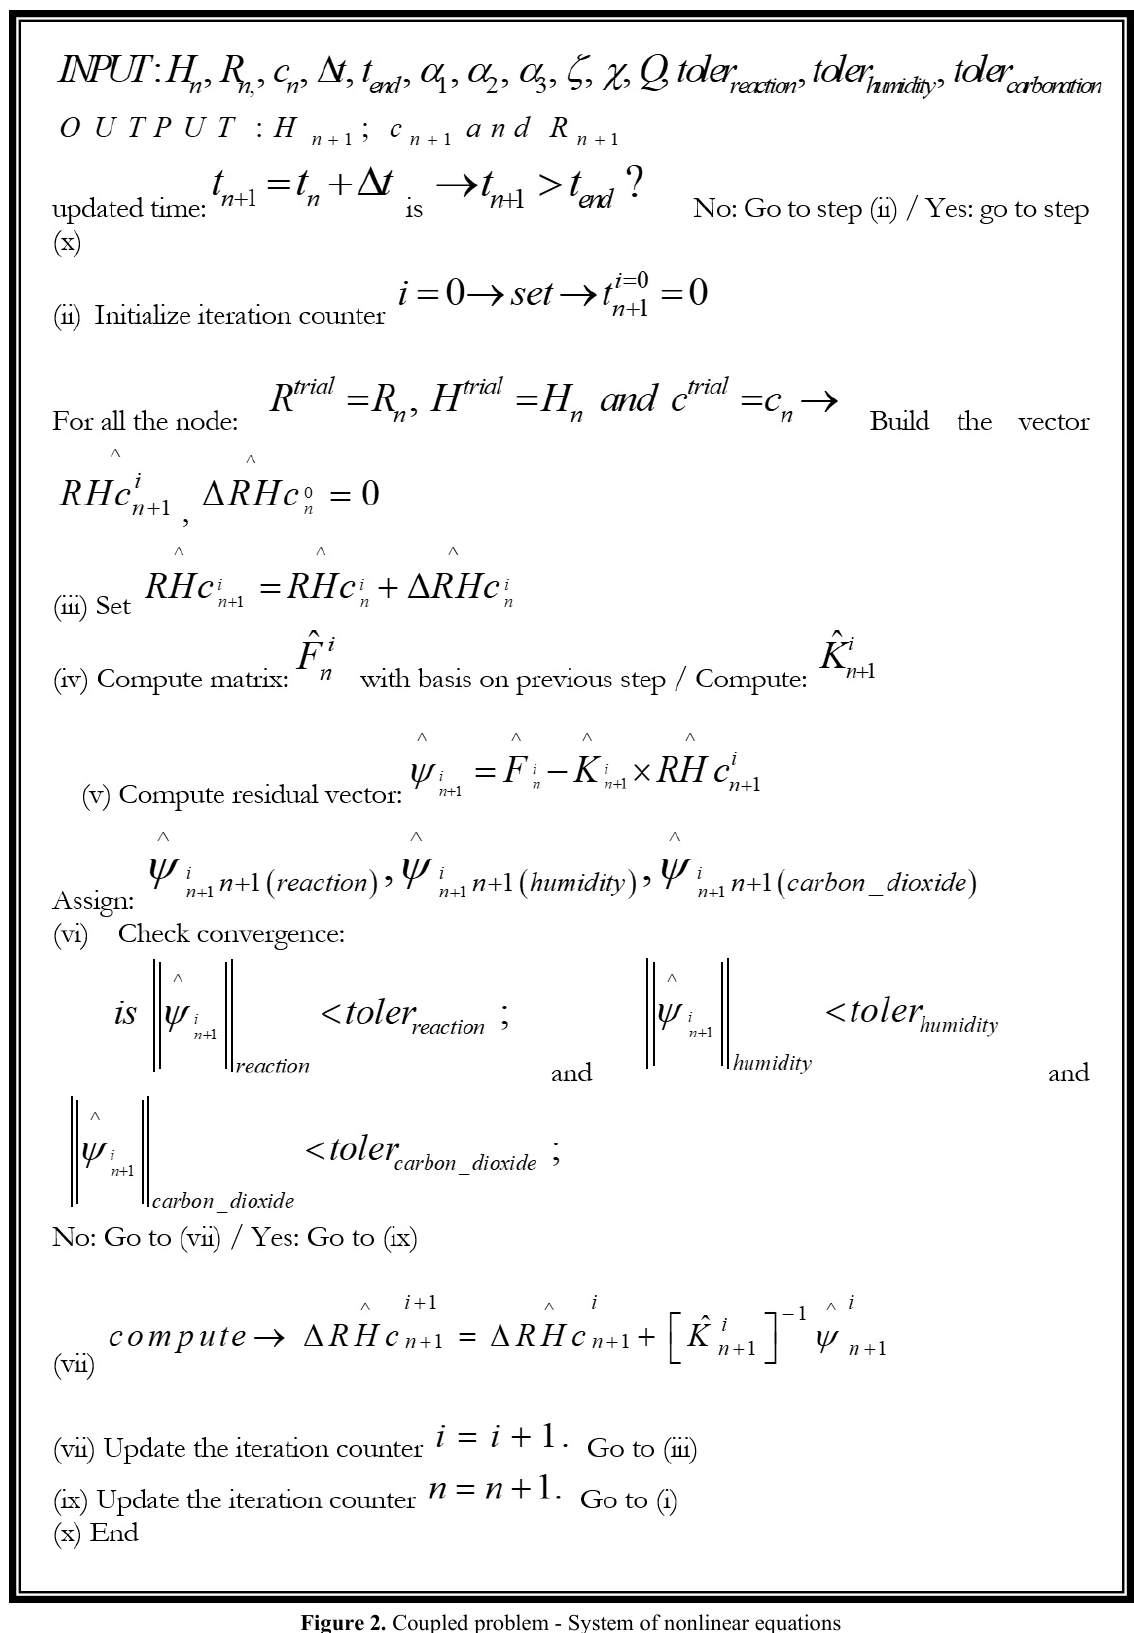
Figure 2. Coupled problem - System of nonlinear